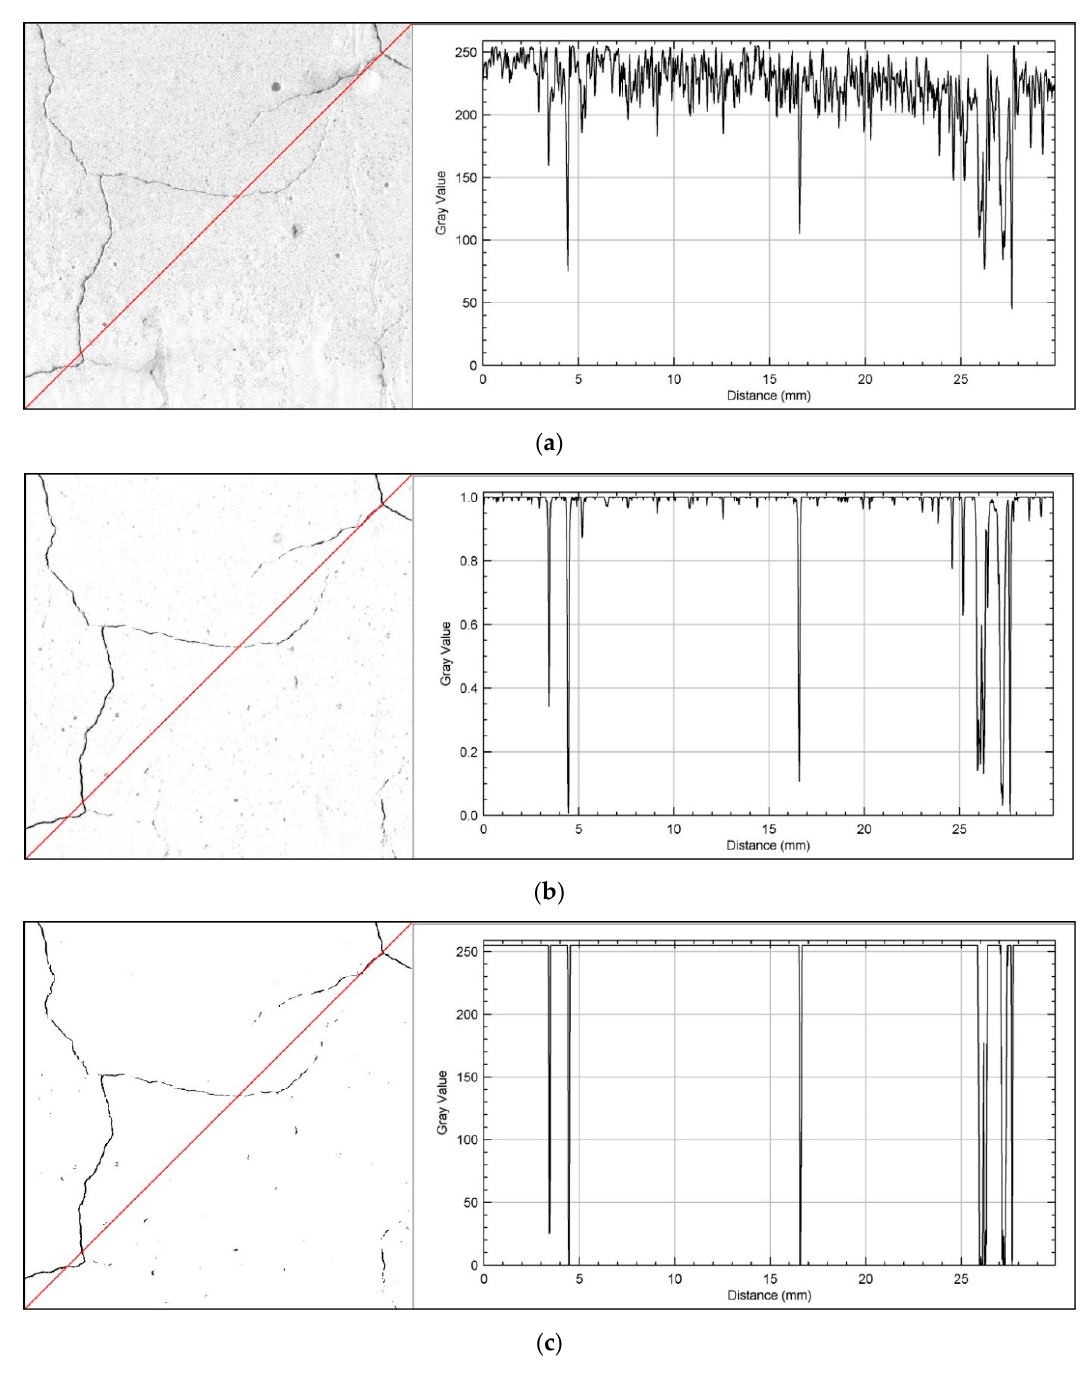
Figure 2. The surface of the pattern for CP32.5 series together with a plot profile showing the gradient value on the greyscale along the red line—the first segmentation stage: ( a ) input image; ( b ) probability map; ( c ) final image.